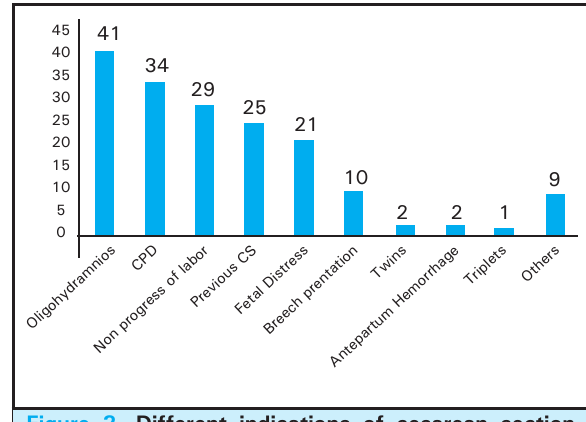
Figure 2. Different indications of cesarean section during the study period.